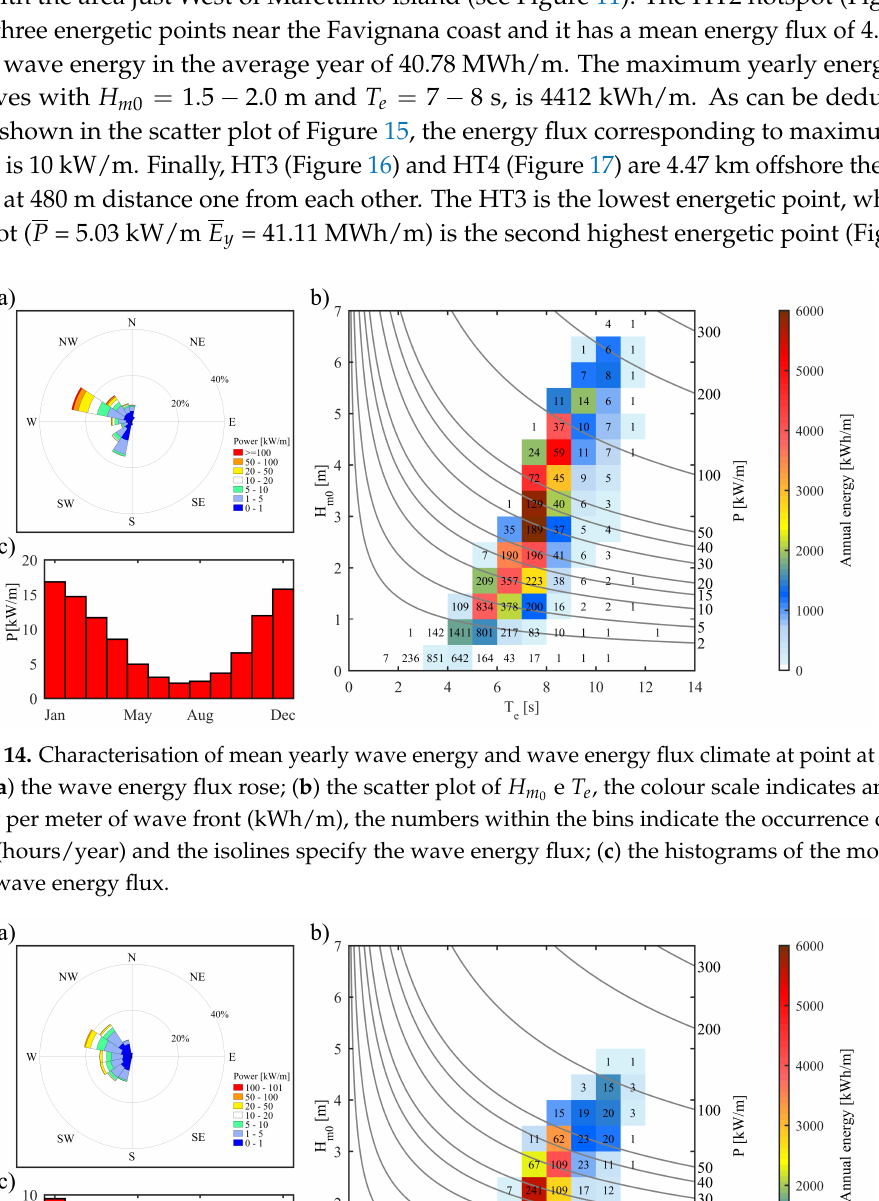
Figure 15. Characterisation of mean yearly wave energy and wave energy flux climate at point HT2; ( a ) the wave energy flux rose; ( b ) the scatter plot of H m e T e , the colour scale indicates annual energy 0 per meter of wave front (kWh/m), the numbers within the bins indicate the occurrence of sea states (hours/year) and the isolines specify the wave energy flux; ( c ) the histograms of the monthly mean wave energy